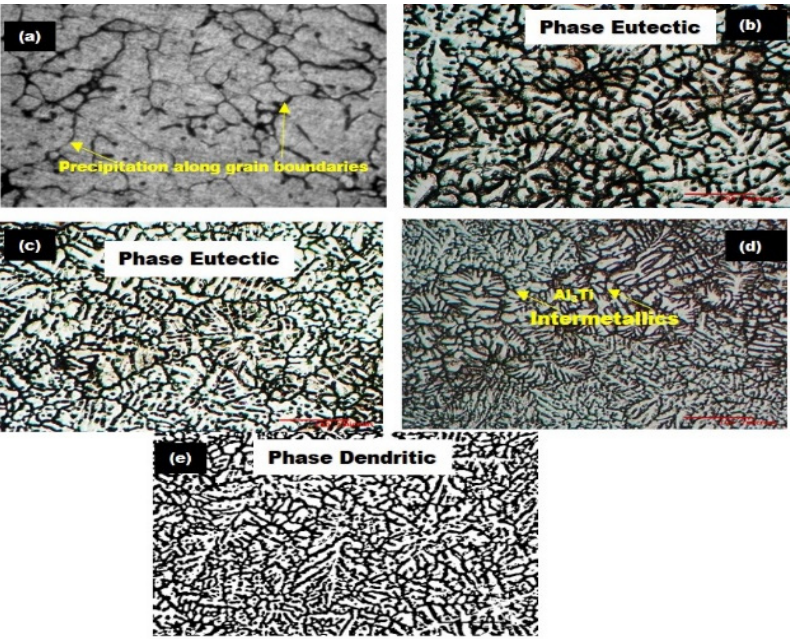
Figure 3. Optical micrographs of Al6061-TiC MMCs at 100 × magnification (scale: 100 µ m): ( a ) Al6061 base alloy; ( b ) Al6061-2 wt.% TiC; ( c ) Al6061-4 wt.% TiC; ( d ) Al6061-6 wt.% TiC; and ( e ) Al6061-8 wt.% TiC.